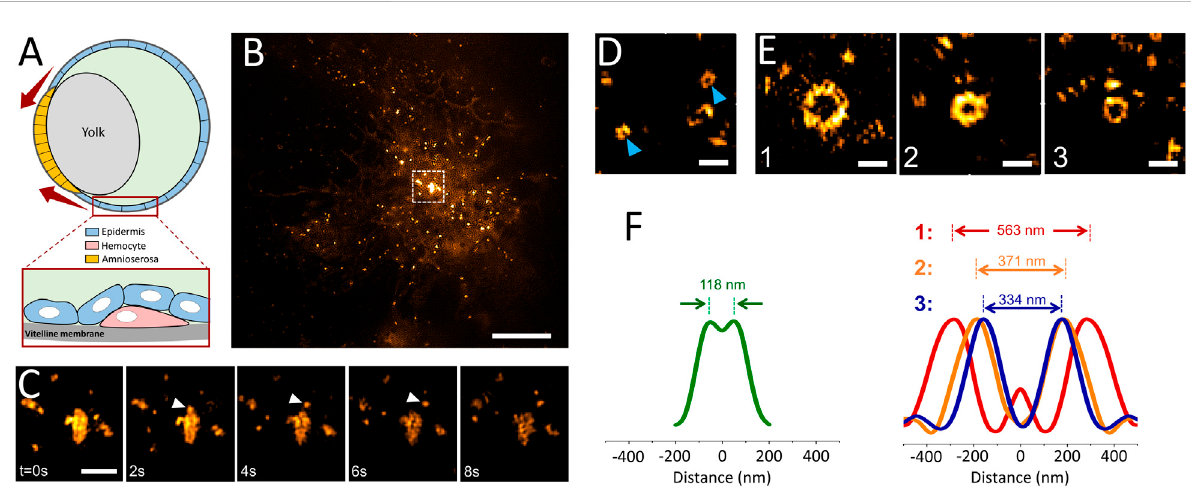
FIGURE 4 Multifarious assemblies of clathrin imaged in tissues of Drosophila embryos. (A) Schematics depicting the cross-section of a late-stage Drosophila embryo during dorsal closure. Drosophila hemocytes (pink) can be imaged by TIRF-SIM as they migrate through the space between the vitelline membrane and epidermis (blue) as seen in Supplementary Video S3. The red arrows represent the increasing tension at the apical surface of the amnioserosa-epidermis interface throughout the dorsal closure. (B) TIRF-SIM image of a Drosophila hemocyte expressing clathrin- mEmerald right above the vitelline membrane of a live embryo. Scale bar, 5 µm. (C) Montage shows the boxed region in (B) , where the arrowheads markacoatfragmentsplitting fromaclathrinplaque.Scalebar,1 µm. (D) Arrowheadsmarktwocanonical CPsimagedwithindeveloping Drosophila embryos expressing clathrin-mEmerald. Scale bar, 0.5 µm. (E) GCPs imaged at the epidermis tissue during dorsal closure of the embryo. Scale bars, 0.5 µm. (F) Left: Radial average of canonical clathrin pit images obtained from embryos, where the peak-to-peak distance is 118 nm. Right: Radial averages of the three GCPs shown in (E) , where the corresponding peak-to-peak separations are 563, 371 and 334 nm,